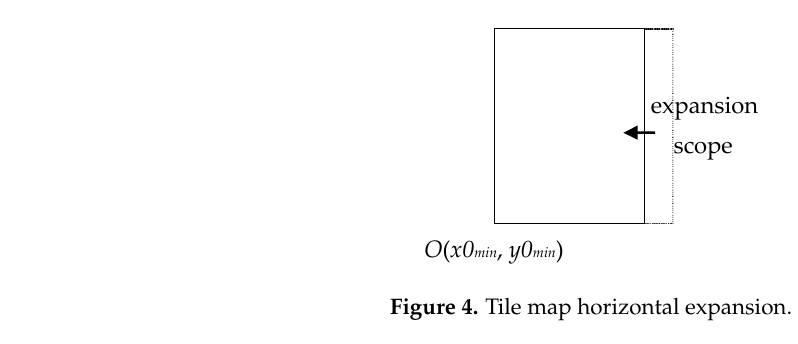
Figure 4. Tile map horizontal expansion.